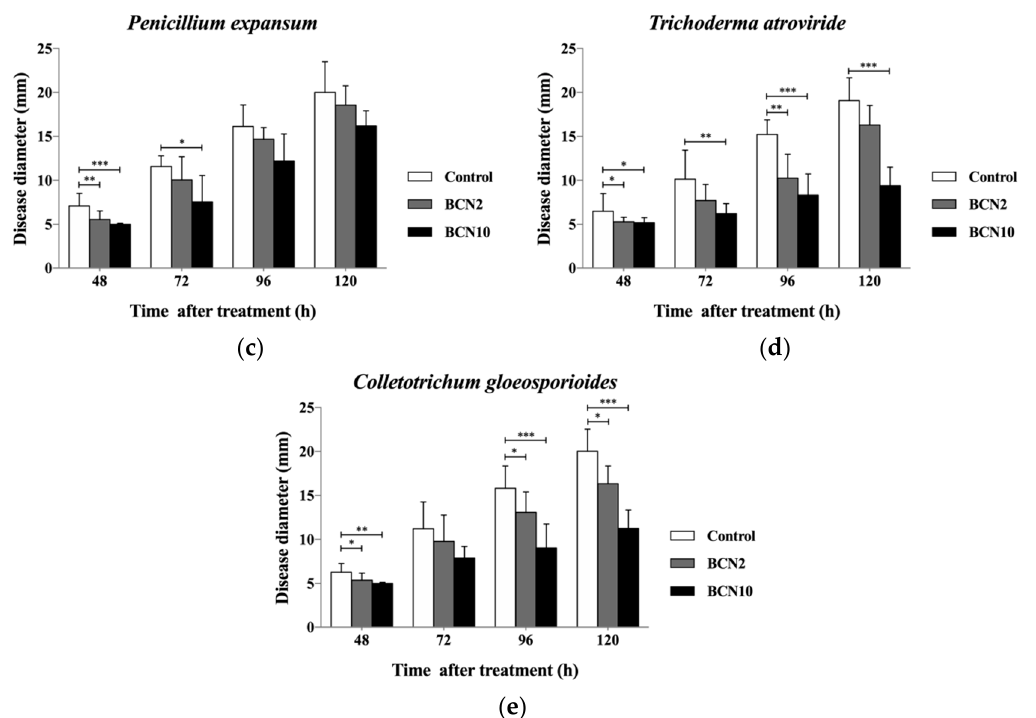
Figure 1. Disease diameter of loquat fruit with treatment of volatile organic compounds produced by two Bacillus strains. The loquat fruits were inoculated with Fusarium oxysporum (a), Botryosphaeria sp. (b), Penicillium expansum (c), Trichoderma atroviride (d), and Colletotrichum gloeosporioides (e) at 25 °C and 85% RH. * p <0.05, ** p <0.01, *** p <0.001 vs control, according to Tukey’s HSD test.